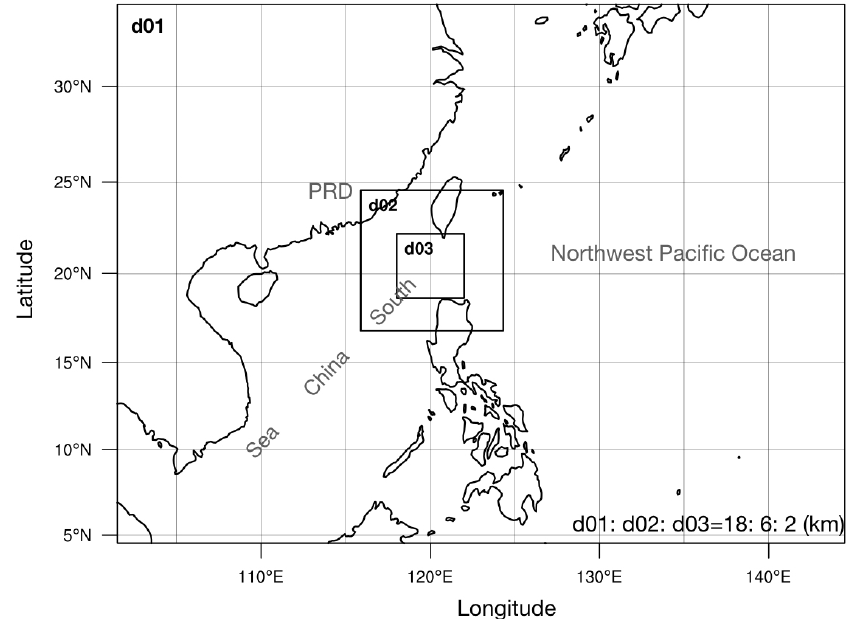
Figure 1. Model domains with triply nested, movable meshes used for the Typhoon Hato (2017) simulation in this study. The inner two meshes (d02 and d03) would automatically track the vortex center during the simulations. Note that the resolution of three domains are 18, 6, and 2 km, respectively. The PRD denotes the Pearl River